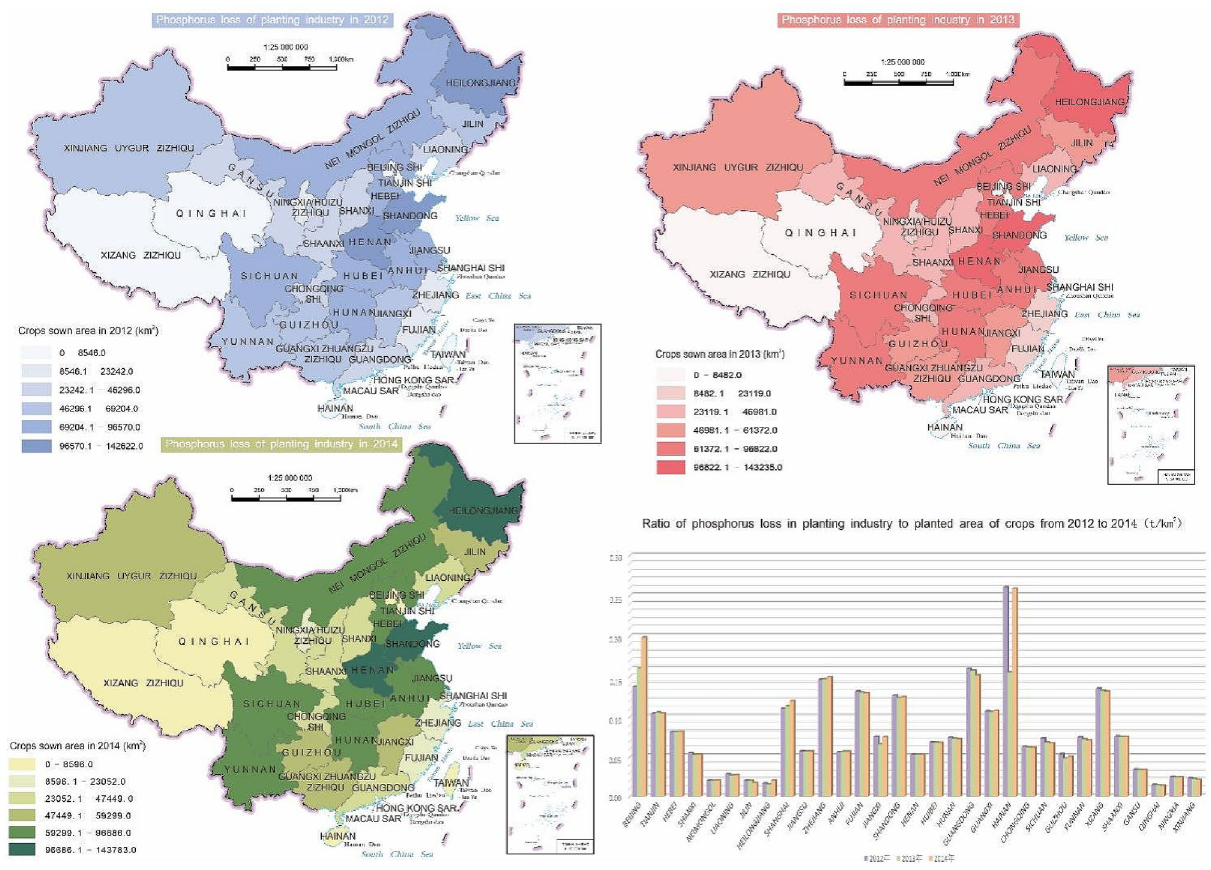
Figure 1. TP loss, crop sown area and the ratio of TP loss to sown area China from 2012 to 2014.